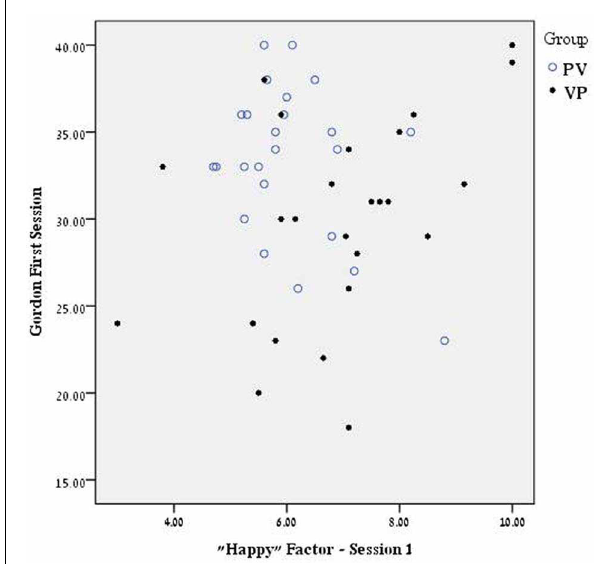
FIGURE 2 | Scatter plot showing the relationship between scores on the factor of “Happy” in the Positive and Negative Affect Scale—PANAS (Tellegen et al., 1988) and Gordon memory scores in the group receiving in the first session AVP (VP) as compared to placebo (PV). Spearman’s rank–order correlations were significant only in the VP Group ( r = 0 . 43, p < 0 .